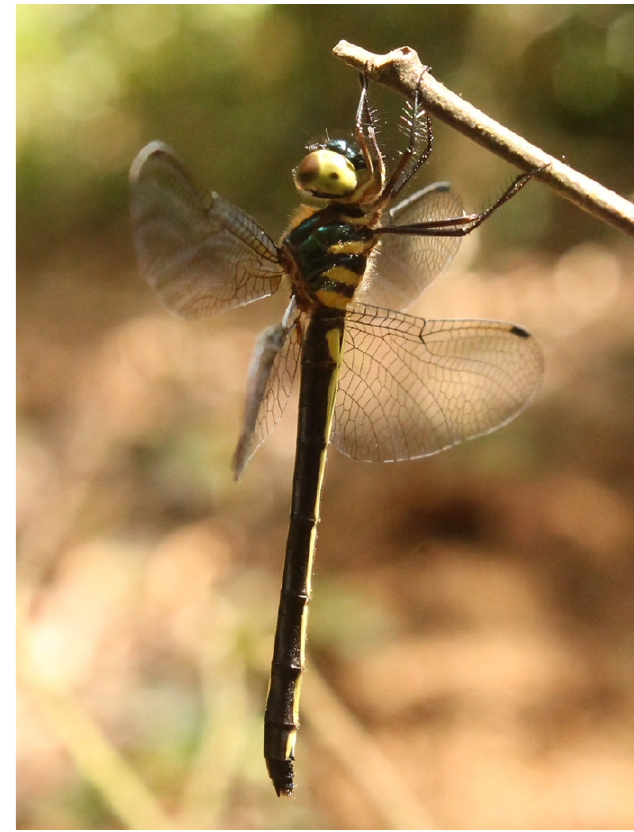
Figure 13. Macromidia donaldi pethiyagodai ♀ .